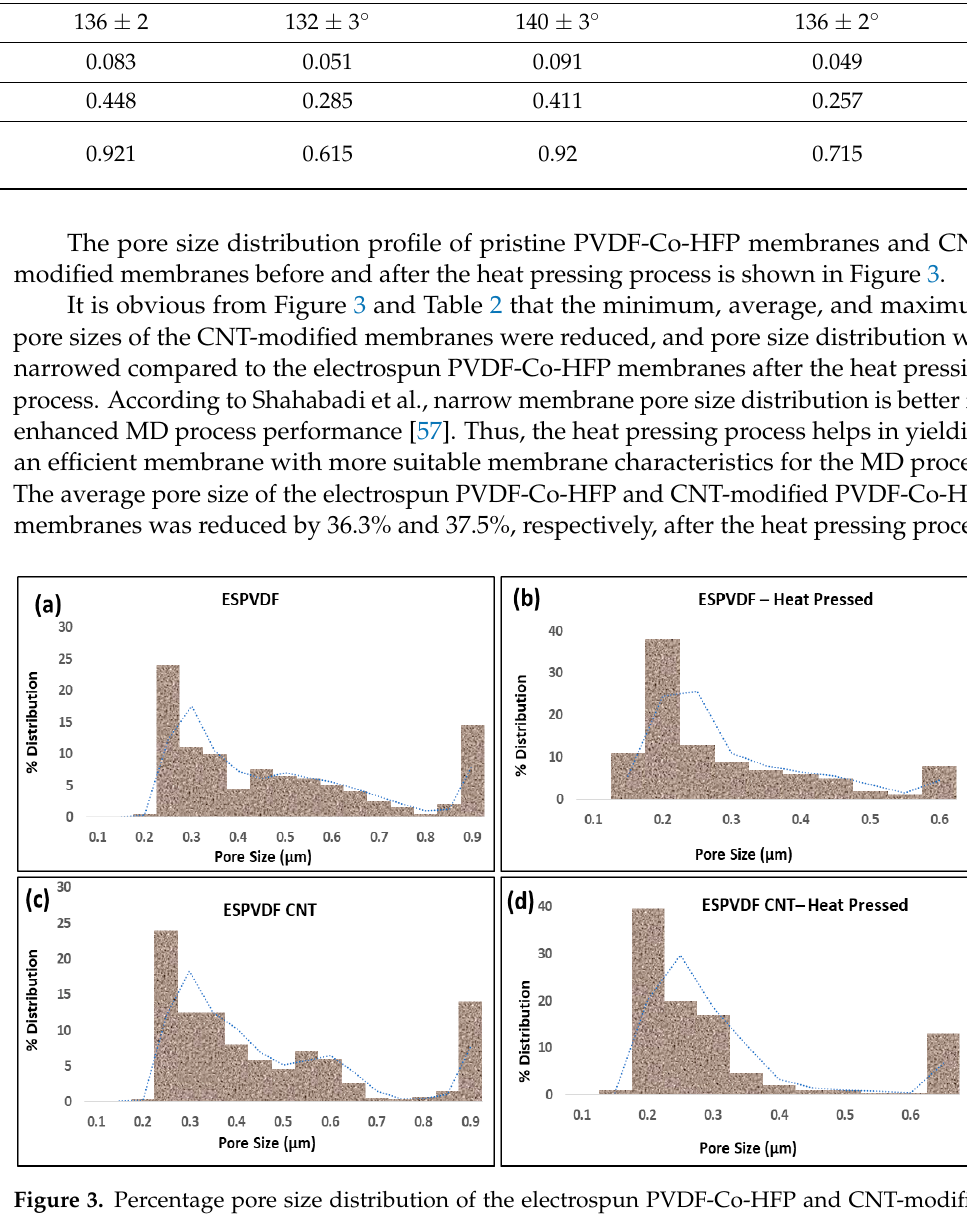
Table 2. Water contact angle and pore size distribution of the PVDF ‐ Co ‐ HFP and PVDF ‐ Co ‐ HFP ‐ CNT membranes.